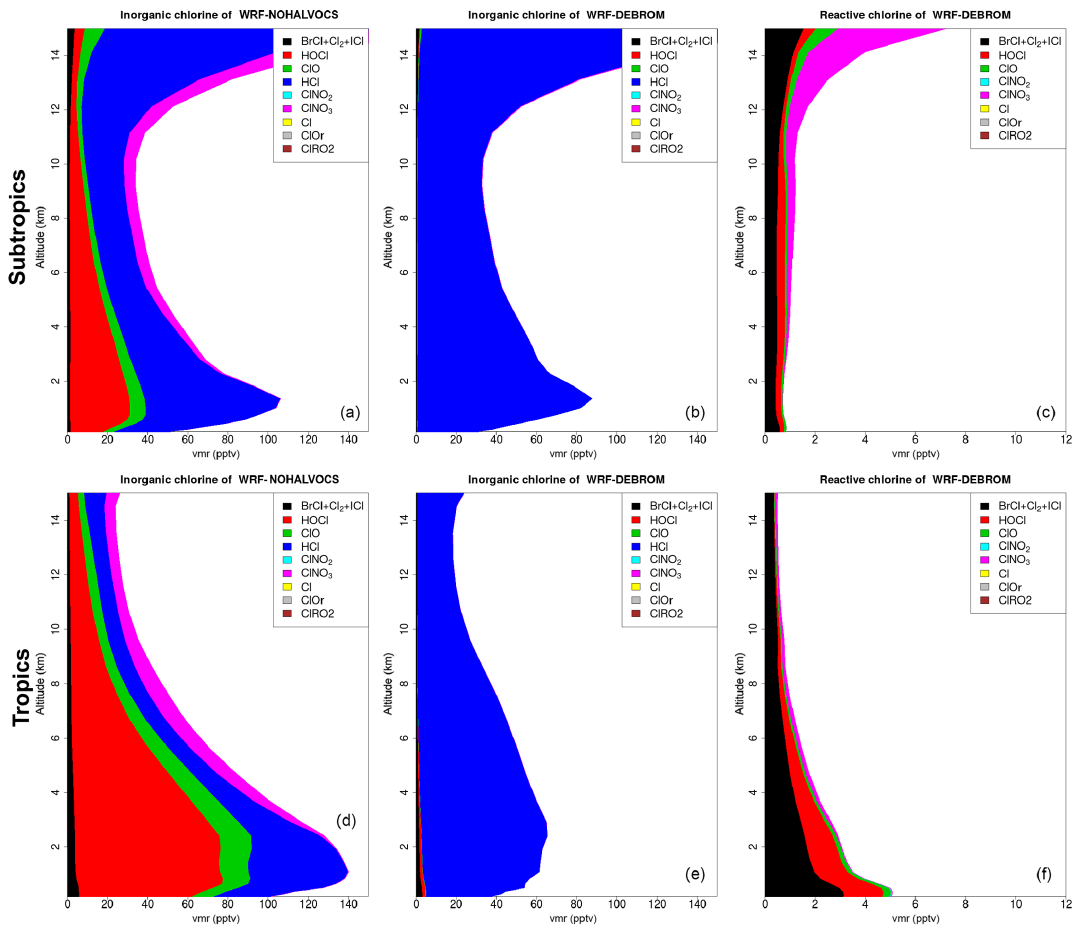
Figure 12. Regional average vertical partitioning of inorganic chlorine (Cl y ) for the two different simulations – WRF-NOHALVOCS (a, d) and WRF-DEBROM (b, e) – during January and February 2012. Regional average vertical partitioning of reactive chlorine species (Cl ∗ ) is also shown (c, f) . Cl ∗ is defined as Cl y gases other than HCl. Panels (a, b, c) are over the subtropical area and panels (d, e, f) over the tropical. Units are in